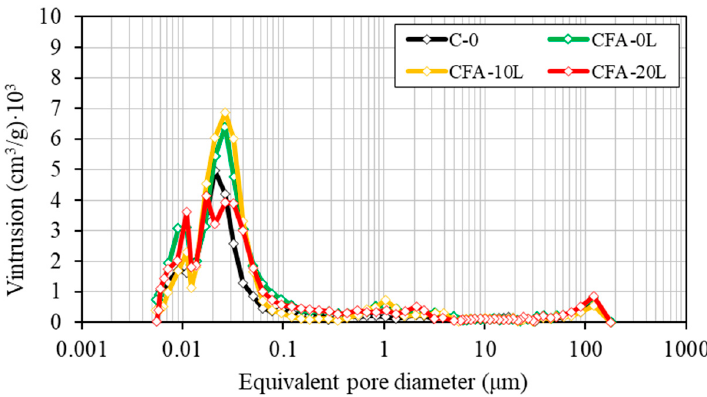
Figure 7. Pore size distribution at the age of 180 days.